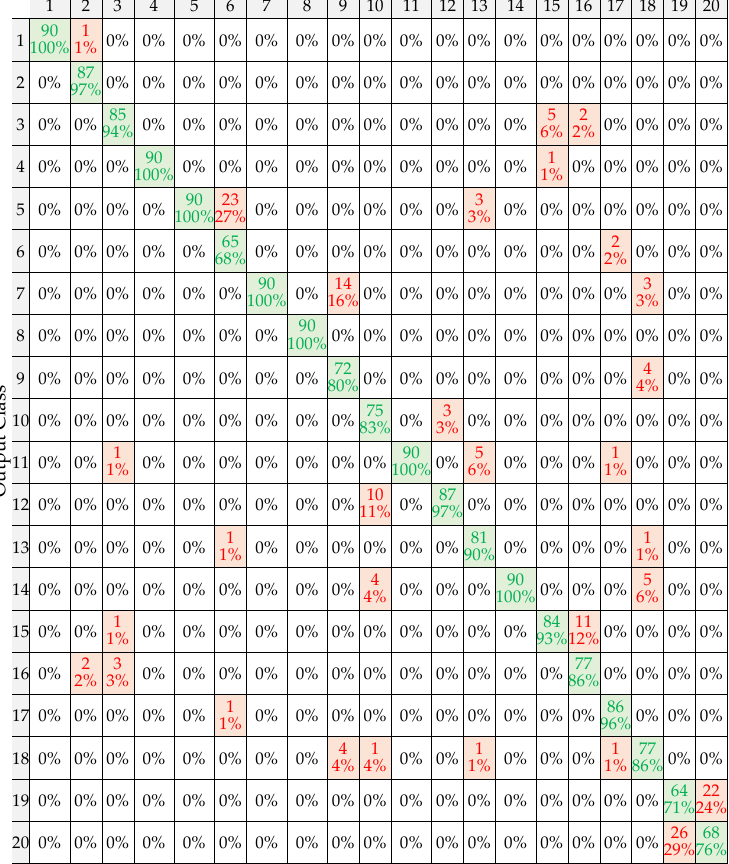
Figure 4. Confusion matrix (moderate SNR range). Table 2. The overall classification accuracies under different SNR levels.